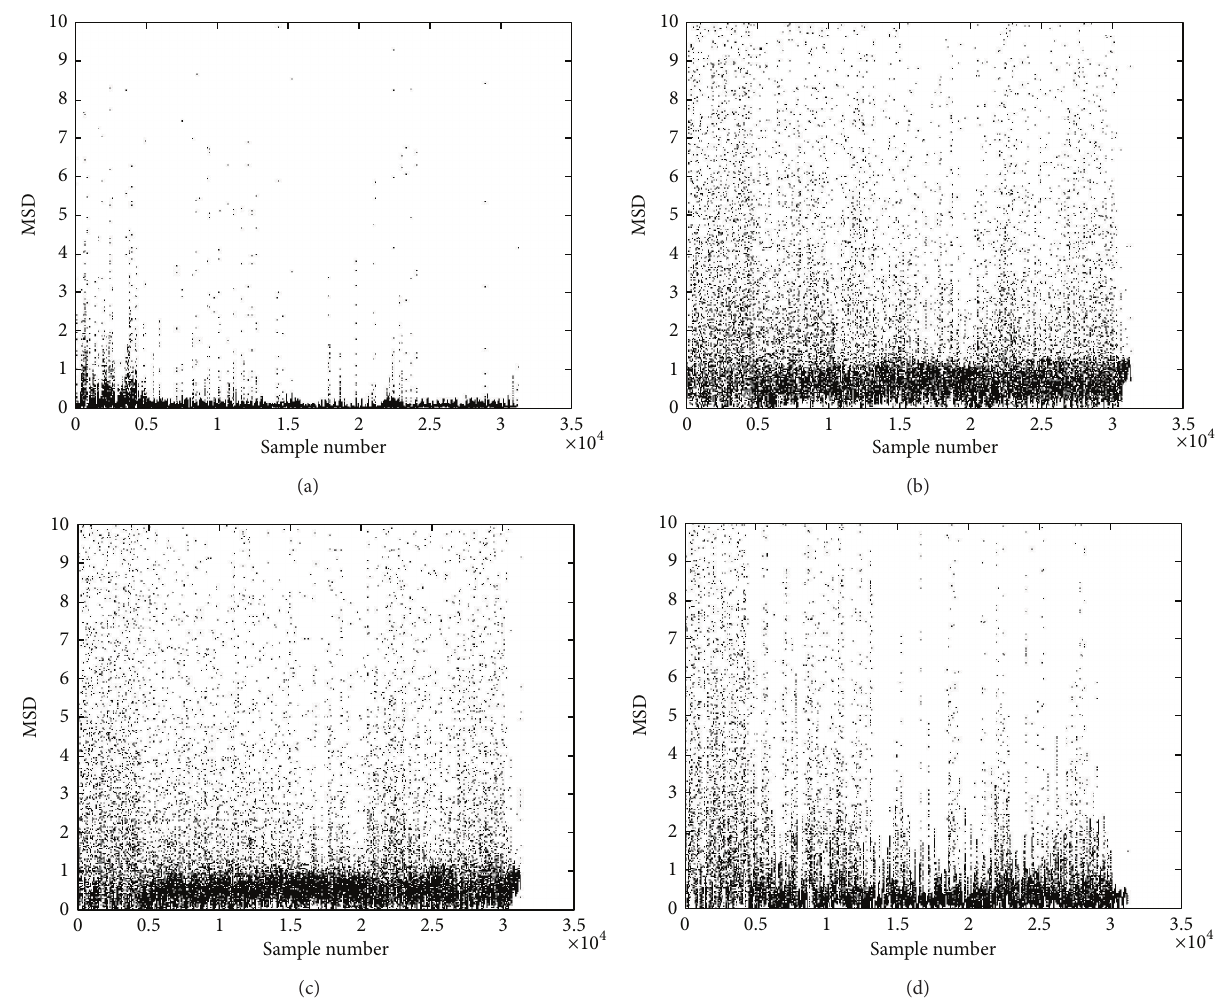
Figure 6: MSD values for frequencies of all sensors. (a) HHT, (b) TEO, (c) HEO, and (d)